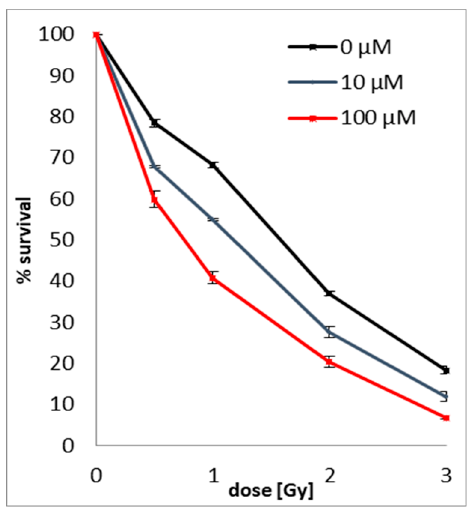
Figure 2. Dose response curves of MCF-7 breast cancer cells treated with (10 µM or 100 µM) or without ISdU. The average plating efficiencies for the controls with and without pre-treatment are equal to 26.31% (0 µM), 23.81% (10 µM), and 21.31% (100 µM). Experiments were performed at least in duplicate, and the results are expressed as mean ± standard deviation (SD).